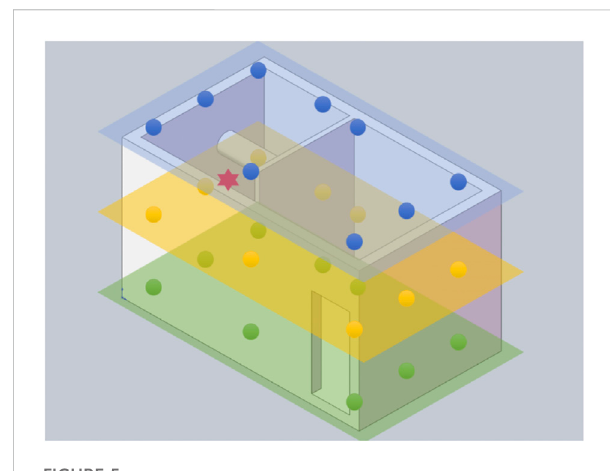
FIGURE 5 Schematic diagram of the Detector ’ s location.